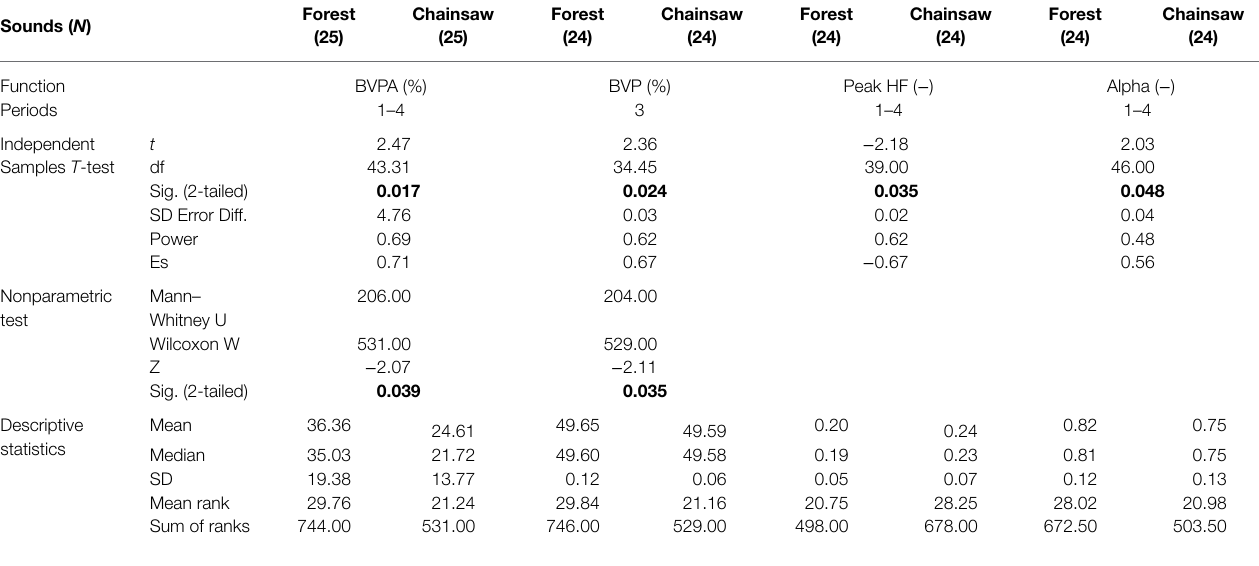
TABLE 1 | Descriptive data and significant (bold text) differences in physiological functions ascertained by T -test for independent samples and the Mann–Whitney test for two independent groups. Sounds ( N )